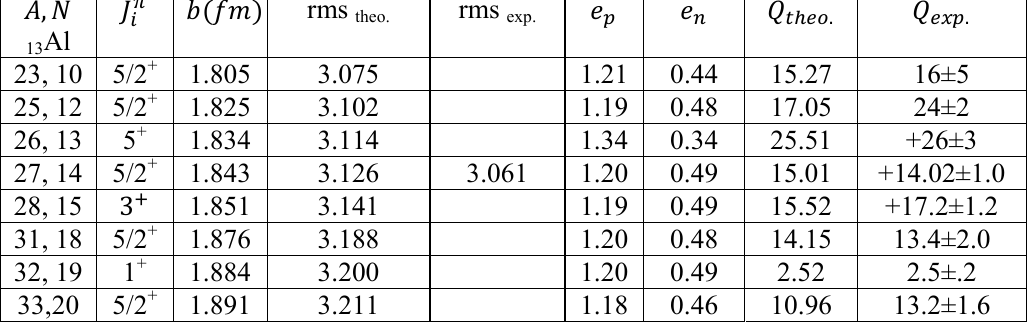
Table 1: Quadrupole moments in units of (cid:2187) (cid:2188)(cid:2195) (cid:2779) calculated with harmonic oscillator (HO) potential for Aluminum (Al) isotopes (Z = 13). Effective charges are obtained from core- polarization calculations. Experimental quadrupole moments are taken from Ref.